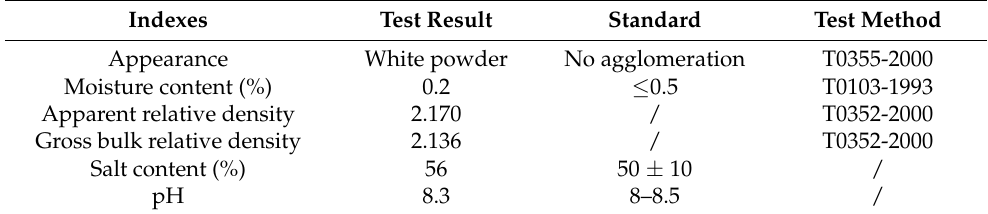
Table 4. Basic properties of Icebane.